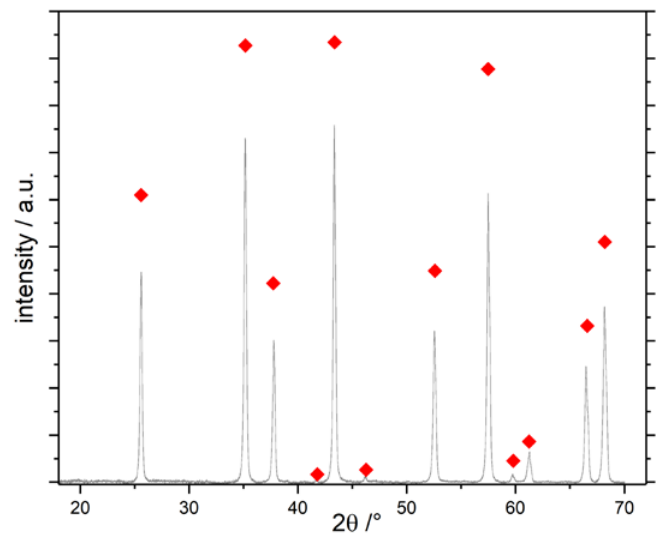
Figure 4. XRD pattern of sample SG-Ref0 after calcination at 1200 °C for 6 h confirms complete transformation to α -Al 2 O 3 . All other samples display the same diffraction pattern.